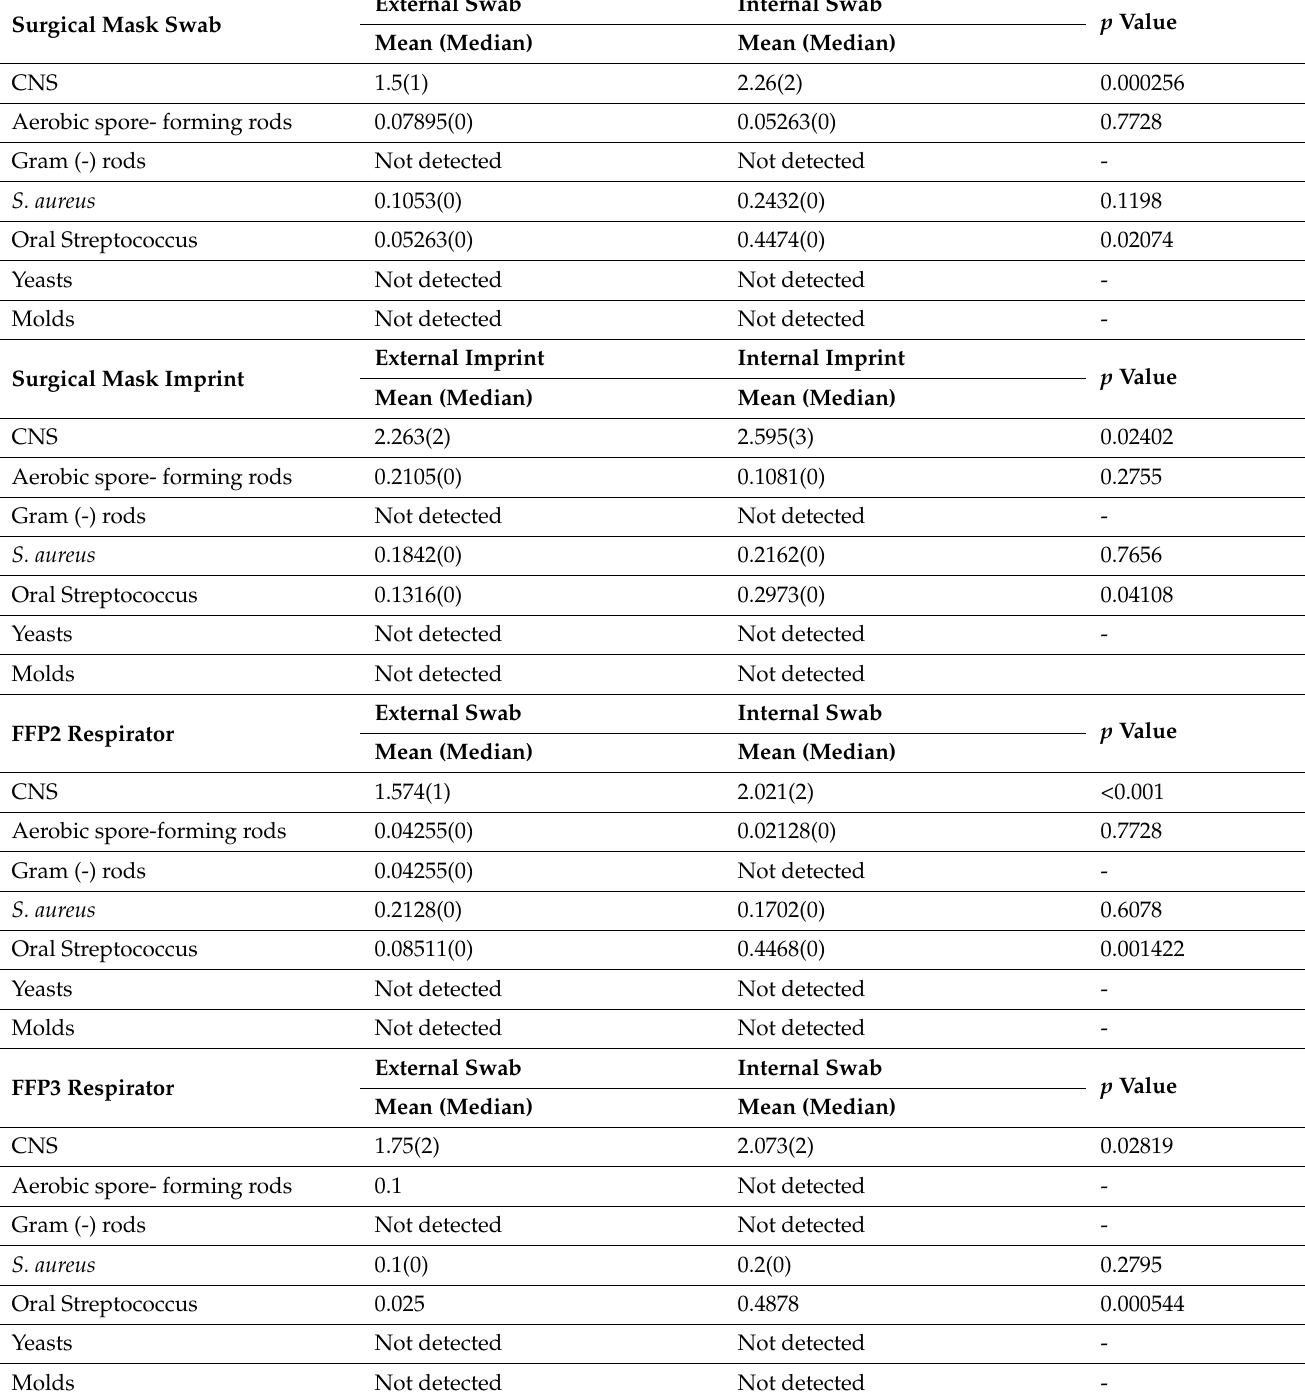
Table 2. Quantitative analysis of species detected on internal and external surface of a given face covering using the Wilcoxon signed-rank test. A p value < 0.05 was considered statistically